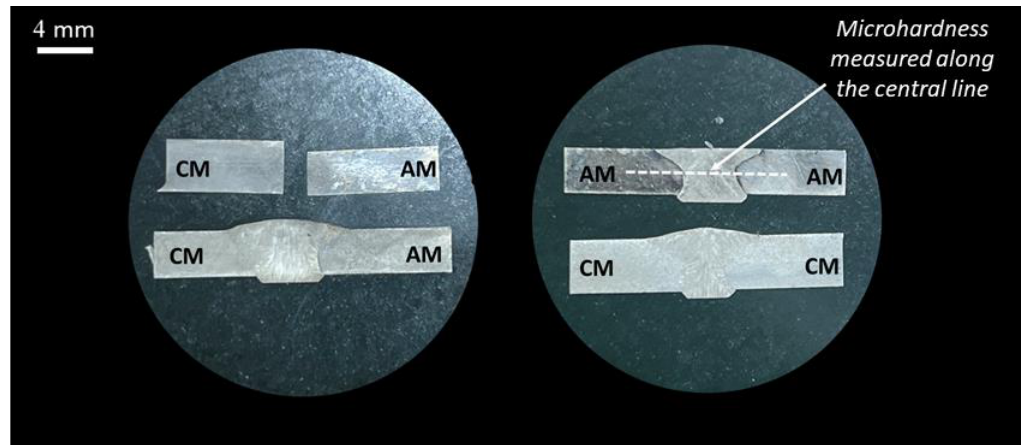
Figure 9. Microhardness and micrography samples.